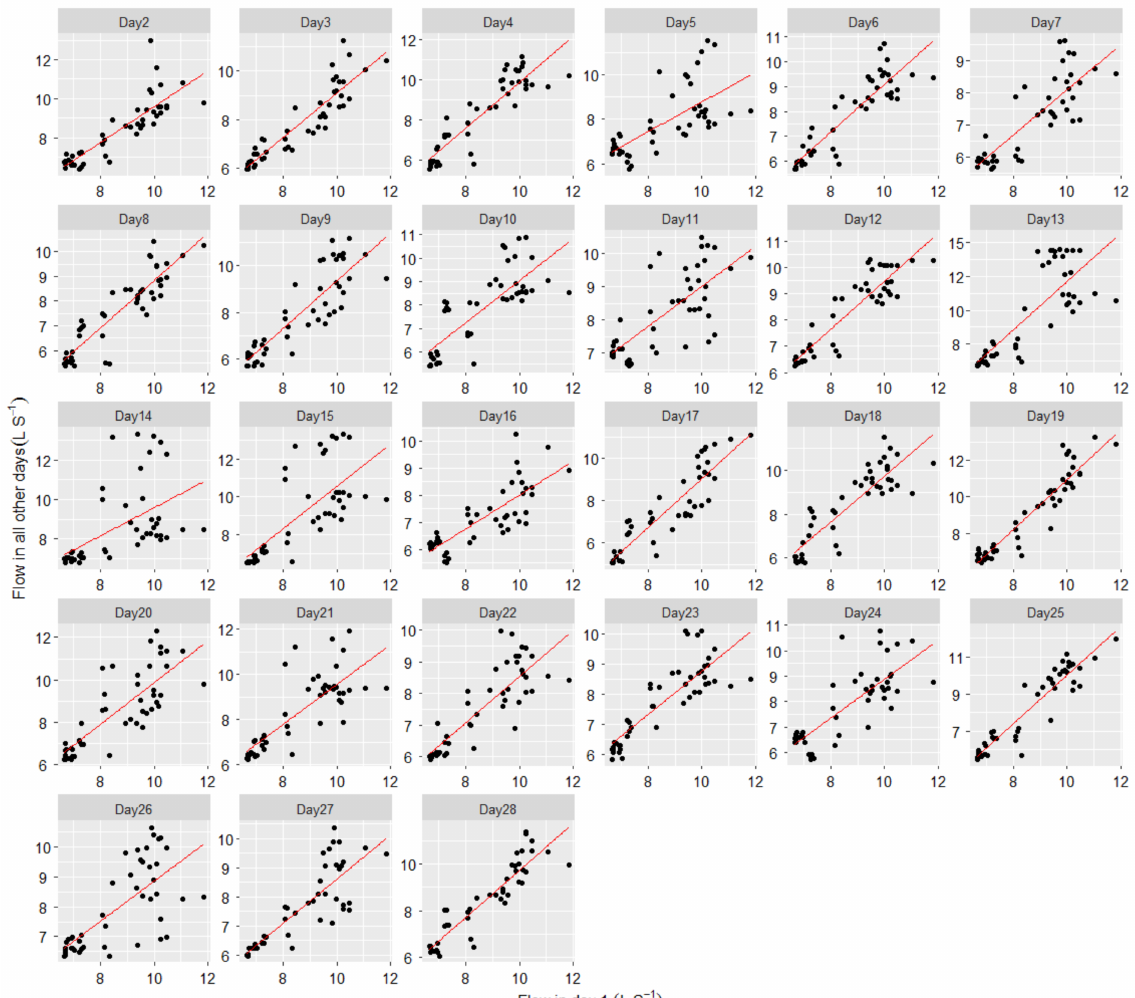
Figure 5. Plot of day 1 flows vs flows on sequential